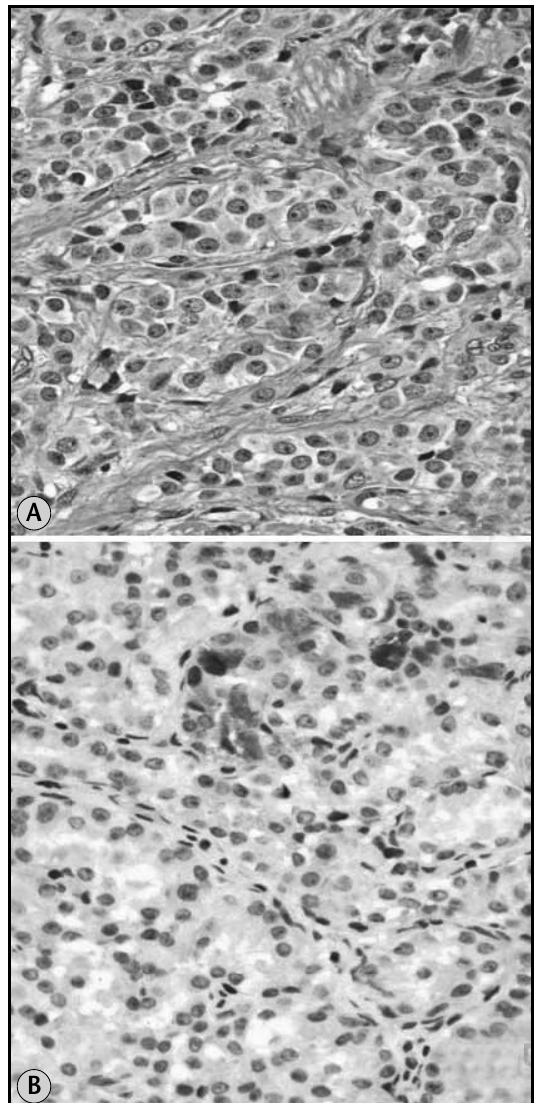
Figure 1 – Microscopic view of well differenciated gastric neuroendocrine tumor. (a) Hematoxylin and eosin staining (400 × ); (b) few ghrelin immunoreactive cells (400 ×